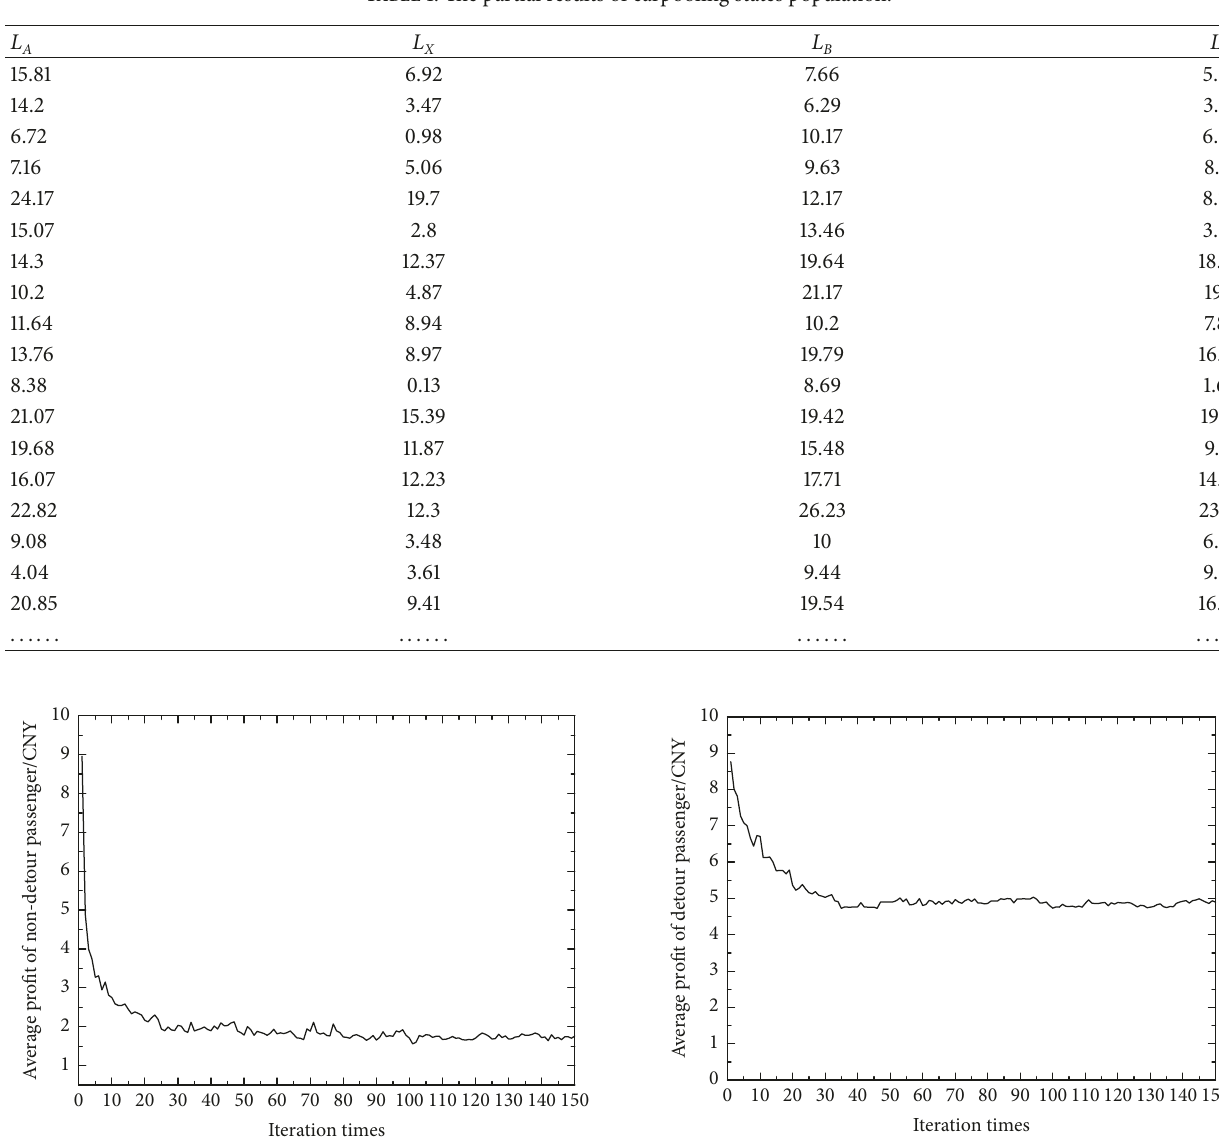
Table 1: The partial results of carpooling states population.